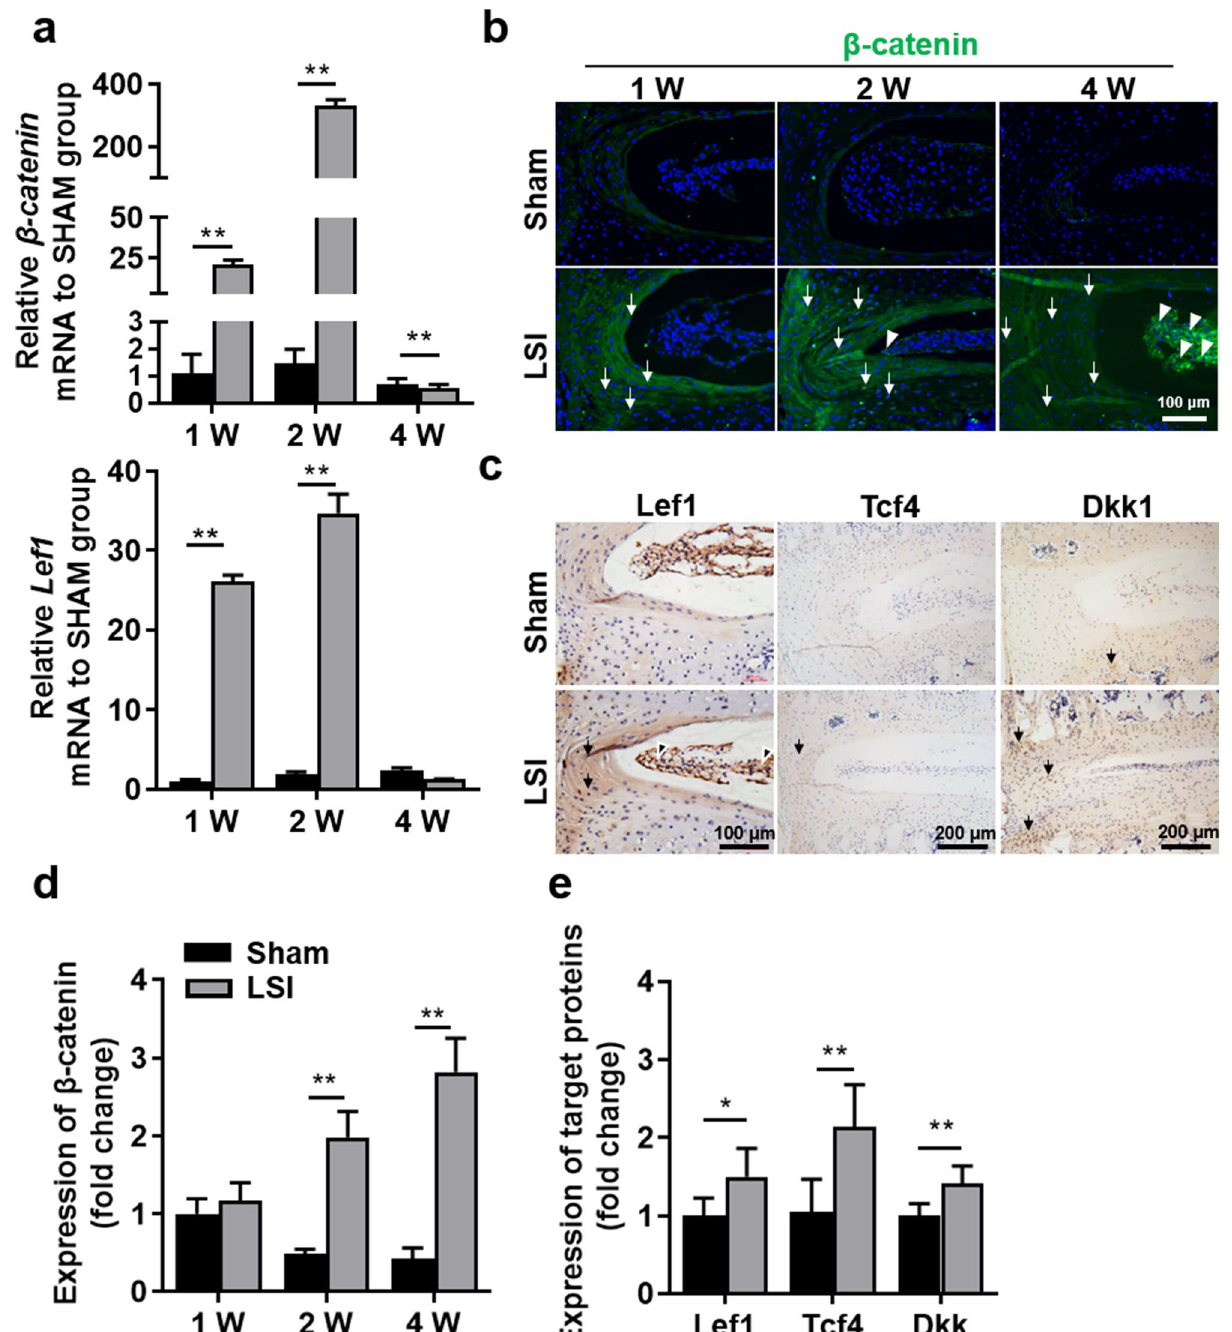
Figure 6. Aberrant mechanical stress activated Wnt/β-catenin signaling pathway of IVD tissues. ( a ) qPCR analysis for β-catenin , Lef1 in the IVD at 1-, 2- and 4-W post-surgery. ( b ) Immunofluorescence for β-catenin in the IVD tissues at 1-, 2- and 4-W post-surgery (green). DAPI stains nuclei blue. White arrowheads indicate high expression of β-catenin in NP. White arrows indicate high expression of β-catenin in AF. ( c ) Immunostaining for Lef1 Tcf4, and Dkk1 in the IVD at 4-W post-surgery (brown). Hematoxylin stains nuclei purple. Black arrows indicate high expression of Lef1, Tcf4 and Dkk1 in AF. ( d ) Quantification of β-catenin expression in IVD of ( b ). ( e ) Quantification of Tcf4, Lef1 and Dkk1 expression in IVD of ( c ). The averages of integrated optical density in interest region was calculated by Image-Pro Plus software version 6.0 (https ://www.media cy.com). Data are shown as mean ± sem. Three independent experiments were performed in triplicate. * P < 0.05, ** P < 0.01 compared to Sham